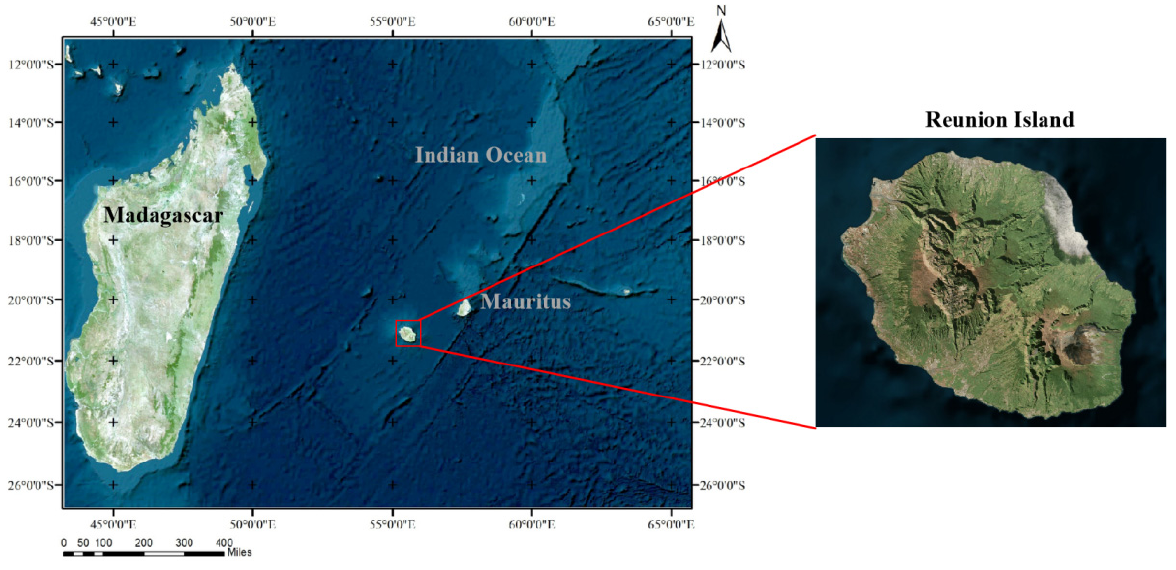
Figure 2. Overview of the Reunion Island Dataset. Table 1. The detailed class distribution on the Reunion Island Dataset.